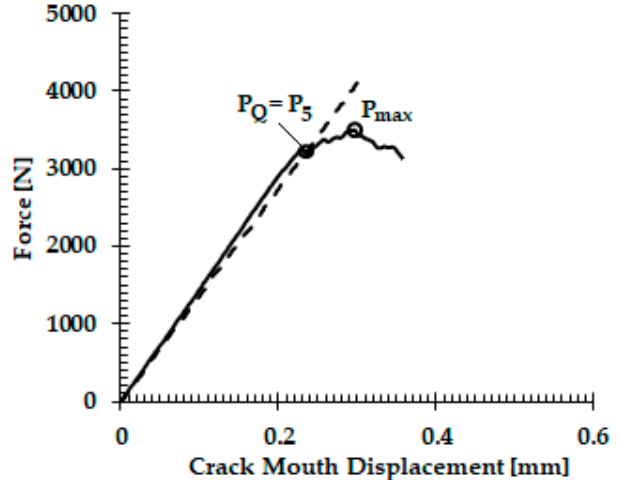
Figure 5. Load vs. crack mouth displacement .